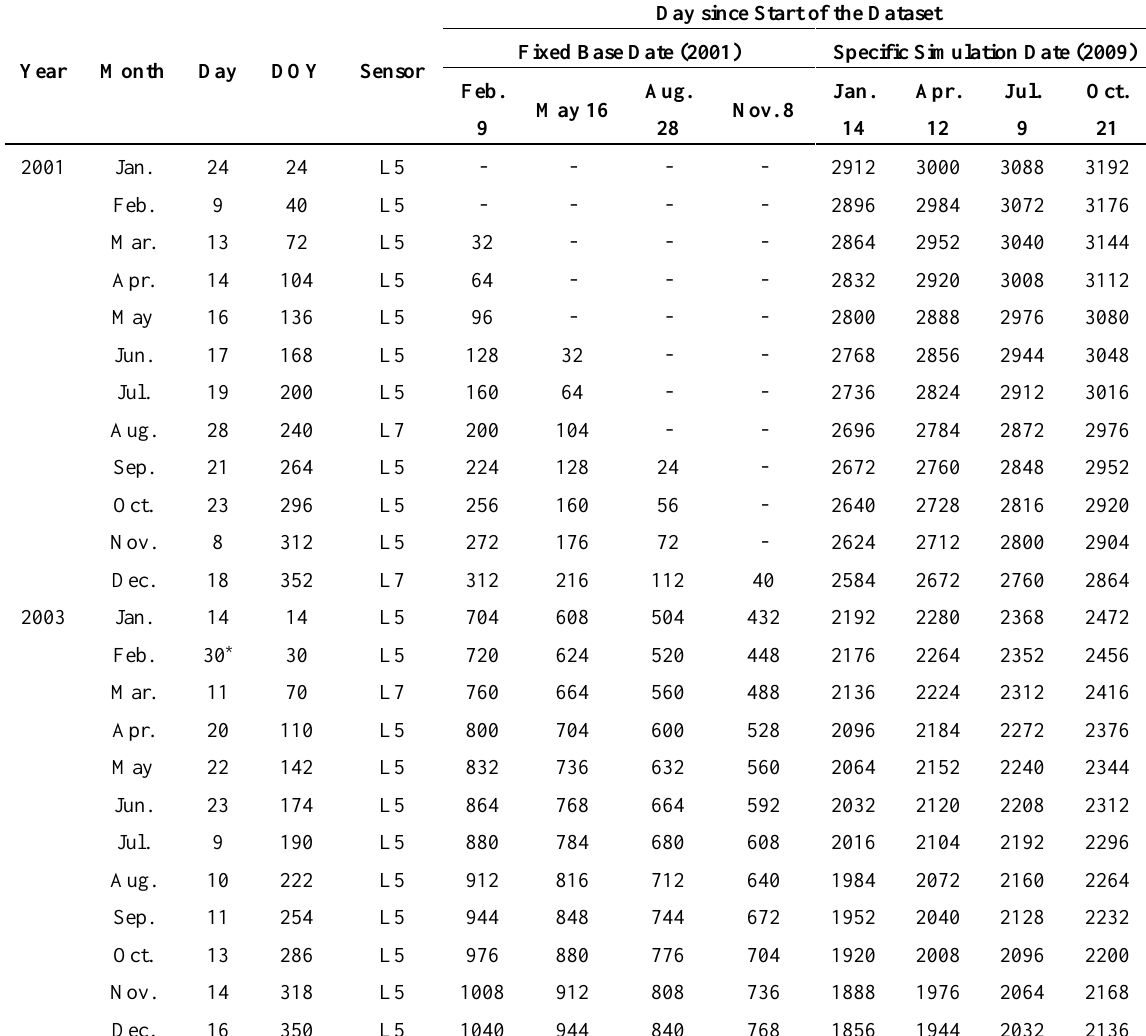
Table 1. Details of the base date for the spatial-temporal image fusion. Abbreviations: